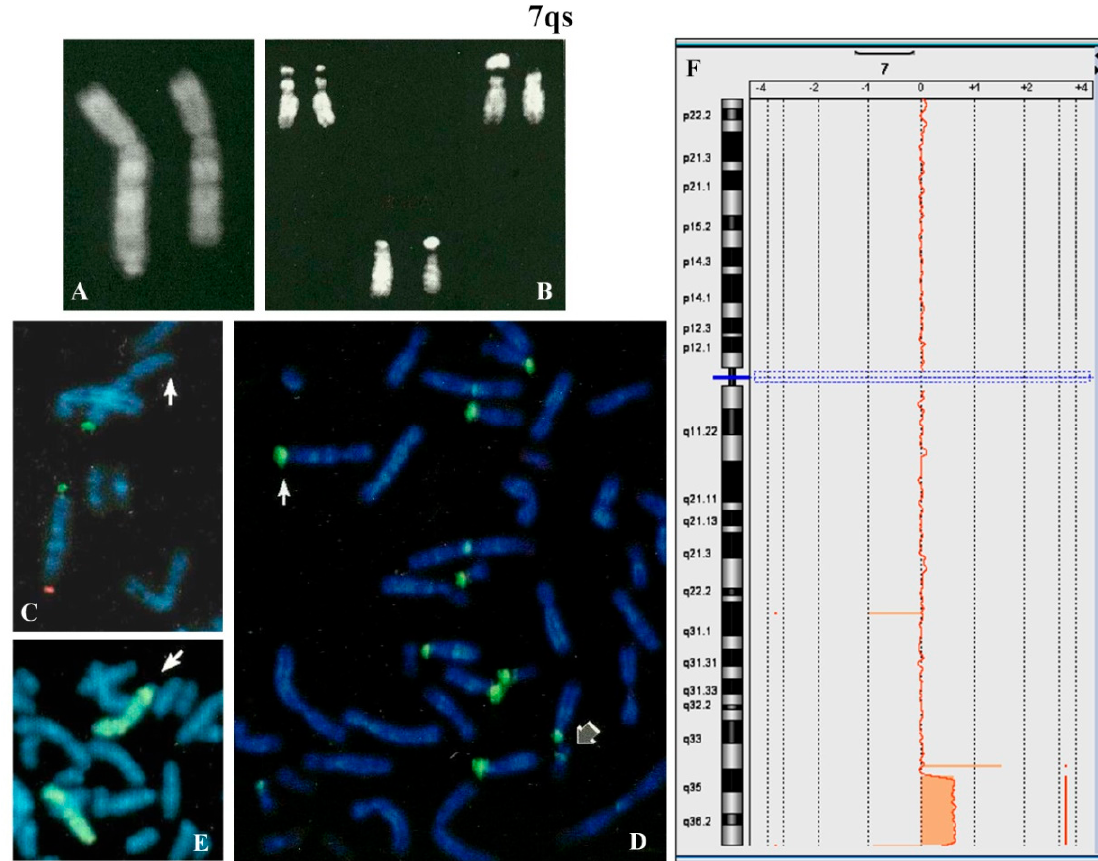
Figure 2. 7qs: ( A ) QFQ banding of chromosomes 7 (7qs on the left); ( B ) chromosomes 22 of father (left), mother (right) and proband (below); ( C ) partial metaphase after FISH with specific subtelomeric probes (green p-arm and red q-arm). Red signal is absent on one chromosome 7 (arrow). ( D ) FISH with β -satellite probe: the white arrow indicates the positive q-arm of 7qs; the gray arrow a chromosome 22 with weak signal. ( E ) partial metaphase after FISH with whole chromosome 7 painting, the arrow indicates the rearranged 7 showing the terminal q region without hybridization. All images were captured at 100 × magnification (see materials and methods for details). ( F ) array CGH showing the larger duplicated and the small terminal deleted regions. The other 2 proximal variants are described as benign copy number variation (CNV) (Database of Genomic Variants, http: // dgv.tcag.ca / dgv / app /